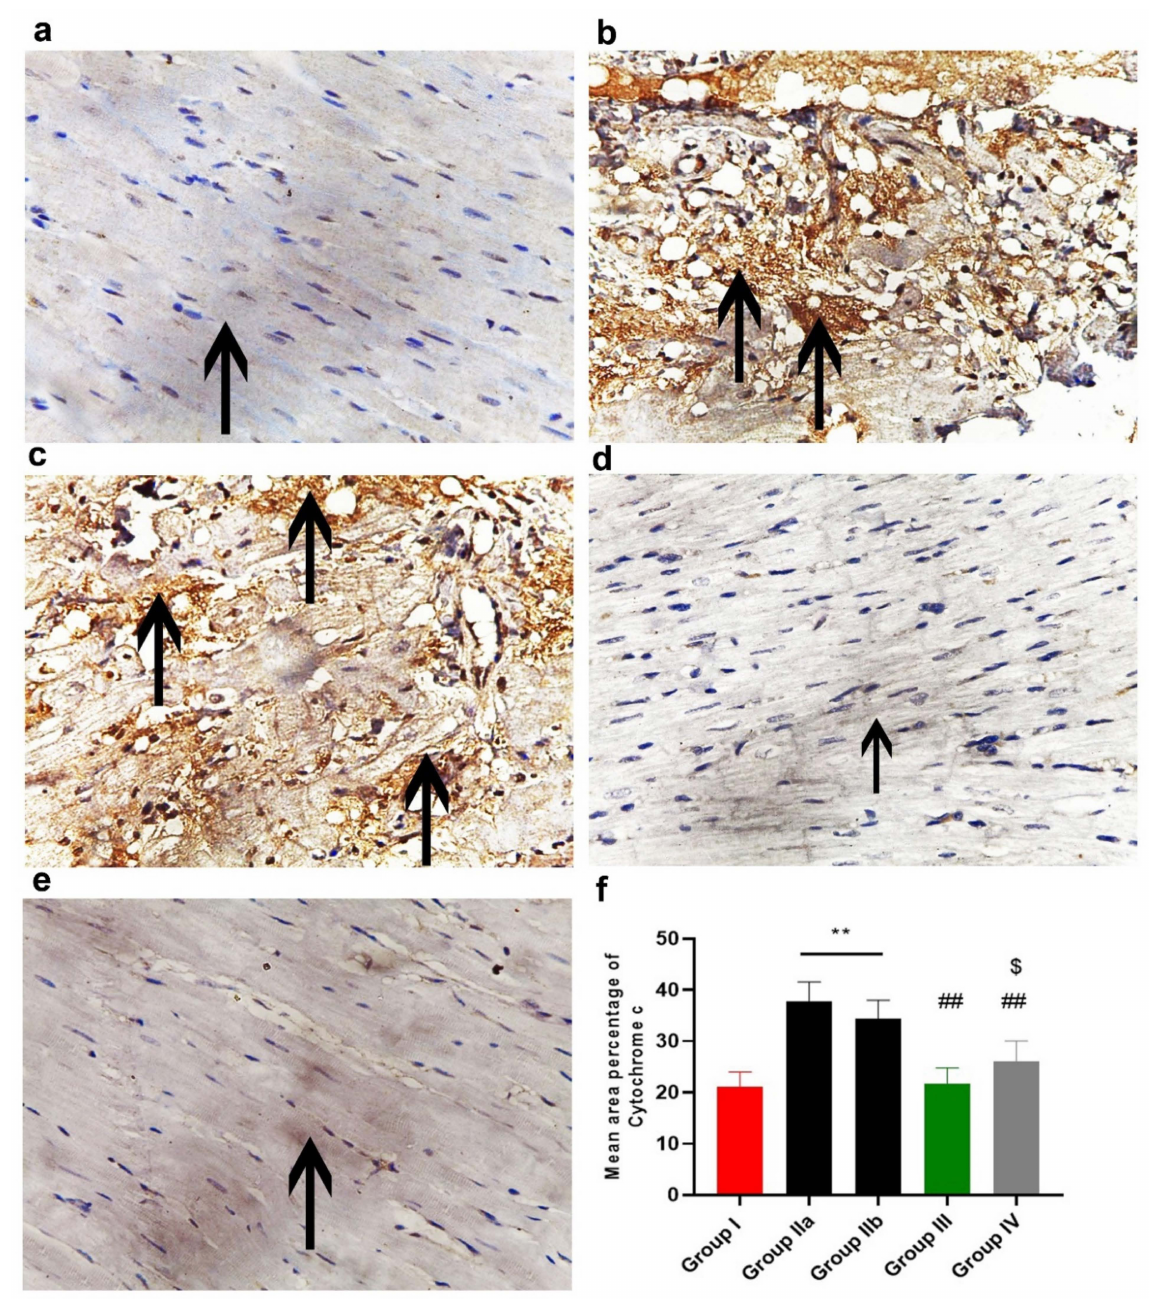
Figure 13. Representative photomicrographs of cytochrome C immuno-stained sections from the left ventricle of the myocardium in the different experimental groups: ( a ) Group I (control group) showed minimal cytoplasmic immune expression of cytochrome C in the myocardium; ( b ) Group IIa (DOX/Trz group) showed marked cytoplasmic immuno-expression of cytochrome C in the myocardium; ( c ) Group IIb (recovery group) showed moderate cytoplasmic immuno-expression of cytochrome C in the myocardium; ( d ) Group III (prophylactic group) showed minimal cytoplasmic immuno-expression of cytochrome C in the myocardium; ( e ) Group IV (curative group) showed few cytoplasmic immuno-expression of cytochrome C in the myocardium; and ( f ) Histogram representing the mean area percentage of cytochrome C immuno-reaction in all experimental groups. **, significant compared to Group I at p < 0.01; ##, significant compared to Group II at p < 0.01; $, significant compared to Group III at p < 0.05; n =